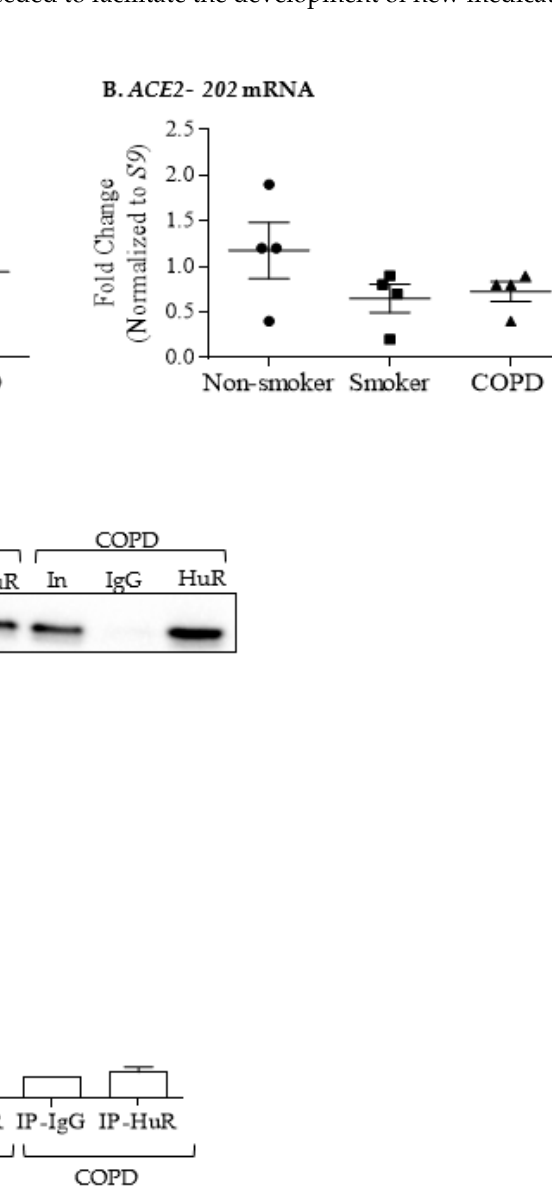
Figure 6. ACE2 mRNA expression and binding to HuR. ( A ) ACE2-201-202 mRNA: there was significantly less mRNA in smoker (triangle) compared to non-smoker (circle) HLFs (* p < 0.05) ( B ) ACE2-202 mRNA: there was no significant difference between the three groups of HLFs. ( C ) RIP — Western blot: representative Western blot of HuR IP is shown. Input (In) refers to cell lysates. IP-IgG refers to immunoprecipitation (IP) with control IgG antibody while IP-HuR refers to the IP with anti-HuR IgG antibody. Note the presence of HuR protein in IP-HuR but not in IP-IgG. ( D ) ACE2-201-202 mRNA: detection of ACE2-201-202 mRNA in IP-IgG and IP-HuR was done using qPCR. Values are expressed as fold enrichment to values measured in IP-IgG. The enrichment of ACE2-201-202 in IP-HuR of HLFs from non-smoker and smoker but not in COPD. Results are presented as the mean ± SEM) (* p < 0.05 compared to IP-IgG).